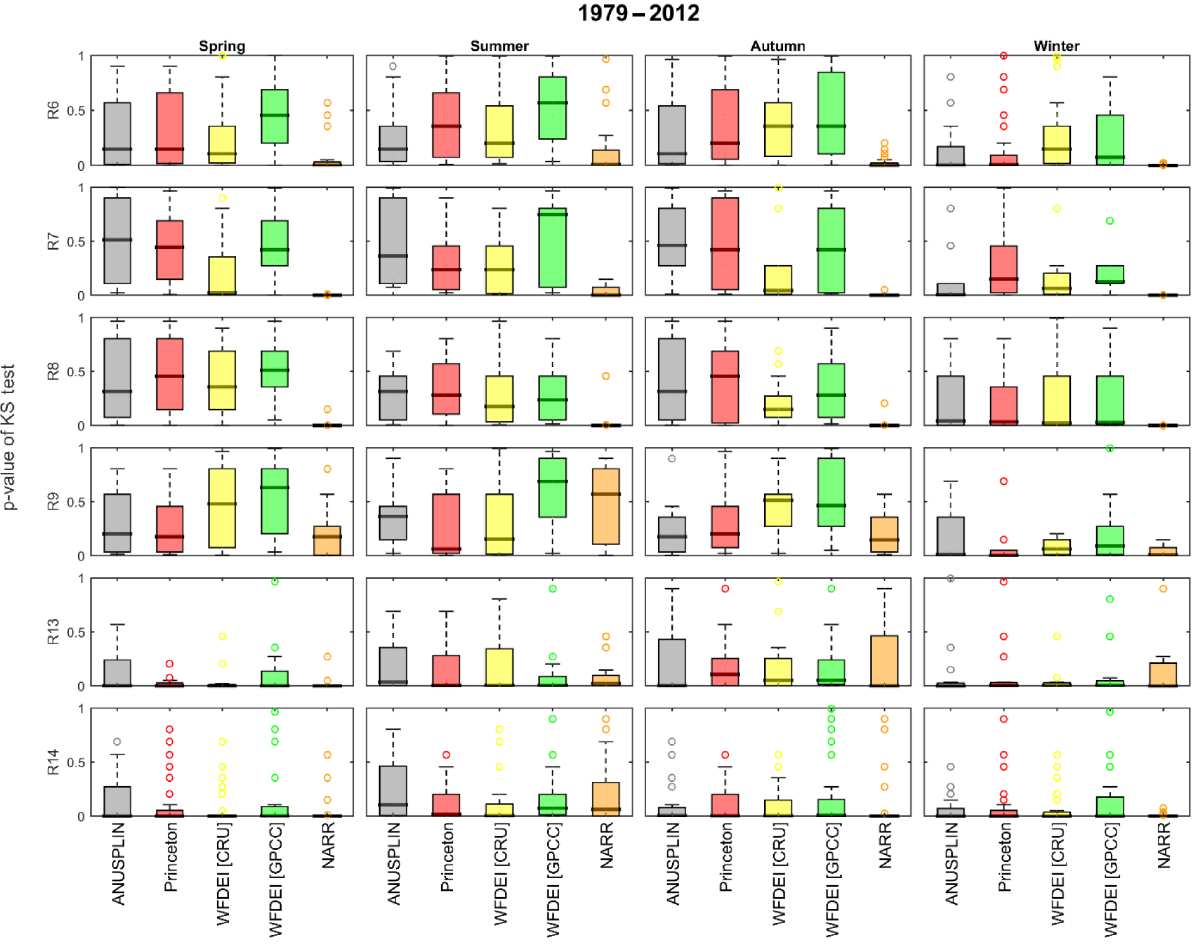
Figure 3. Distributions of p value of the K–S test in four seasons for the period of 1979 to 2012 (long-term comparison without CaPA). Note that the numbers of precipitation-gauge stations in each ecozone are different (see Table 4). The p values of regions 6 to 9, and 13 to 14 (R6–R9 and R13–R14), which are more than or equal to 10 stations, were only shown for illustration in box-and-whisker plots with bottom, band (black thick line), and top of the box indicating the 25th, 50th (median), and 75th percentiles